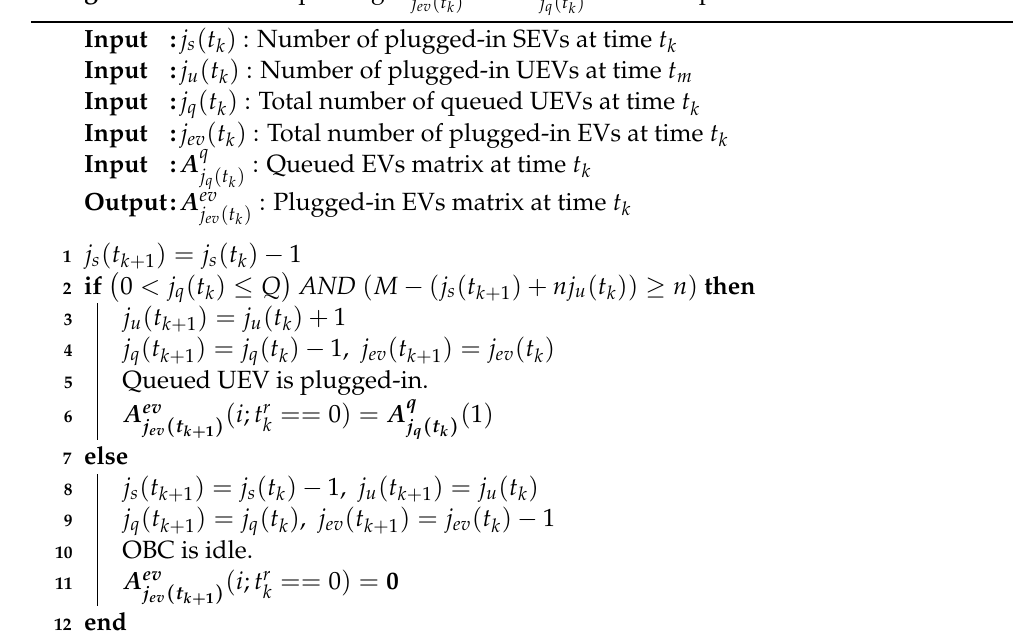
and A q at SEV departures. j ev ( t k ) j q ( t k )